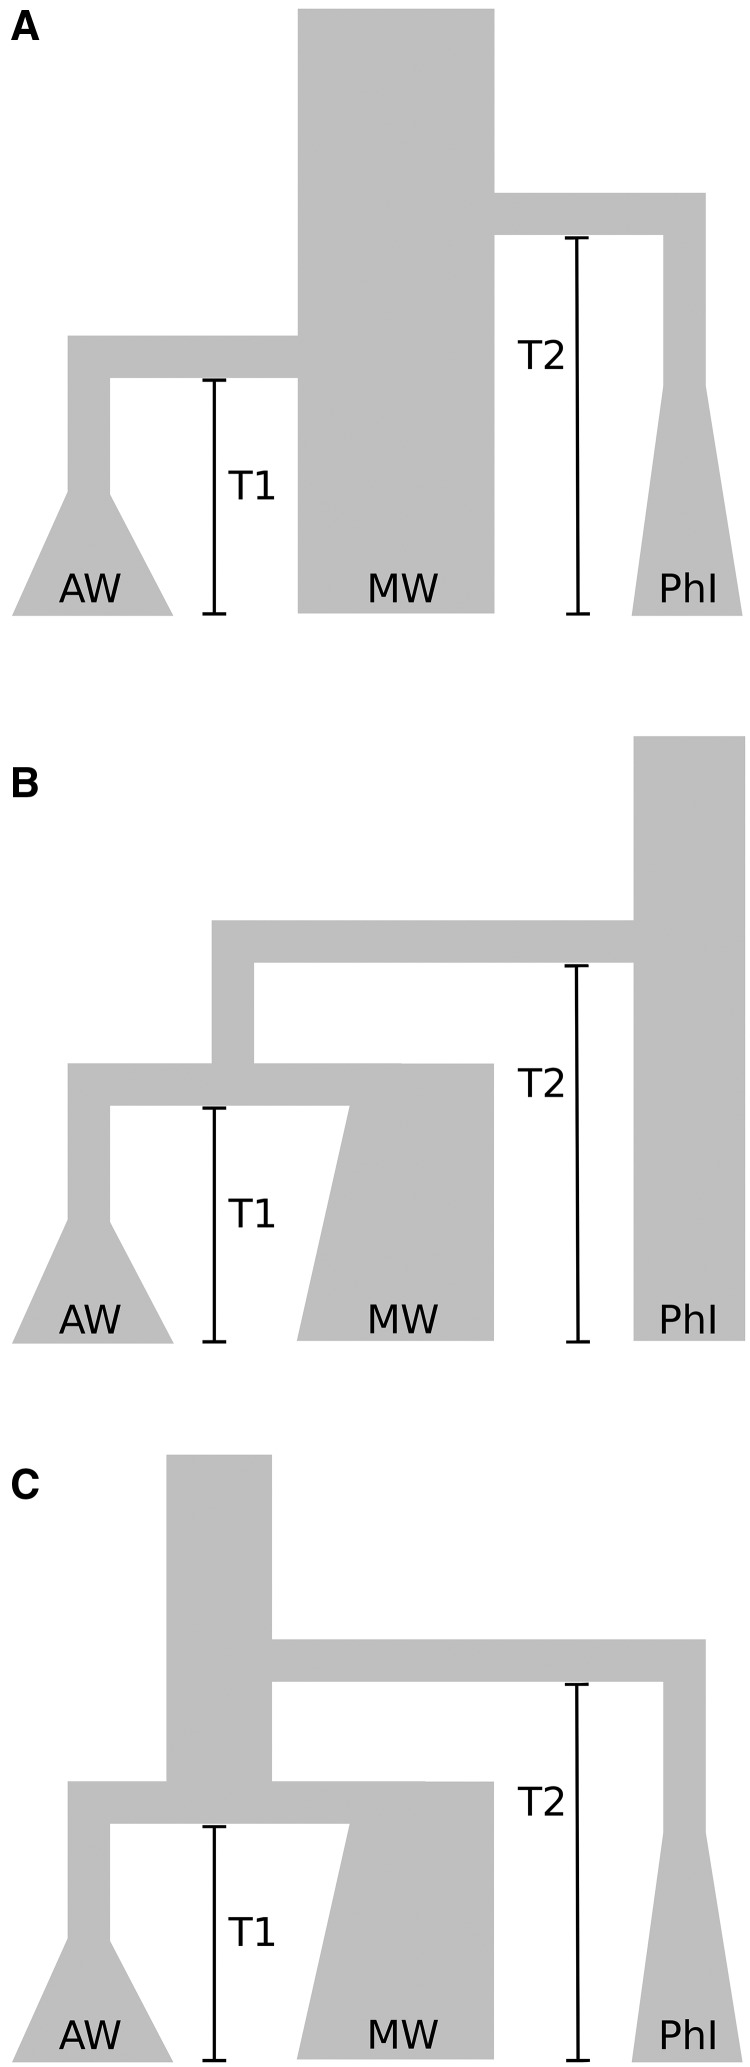
Graphical representation of the different demographic models compared in the current study. (A) Mesoamerican model where the Mesoamerican wild (MW) population did not experience any population bottleneck; (B) the Northern Peru–Ecuador model where the Northern Peru–Ecuador (PhI) gene pool did not experience any population bottleneck; and (C) the Protovulgaris model where the ancestral population went extinct after the Mesoamerican and Andean differentiation.